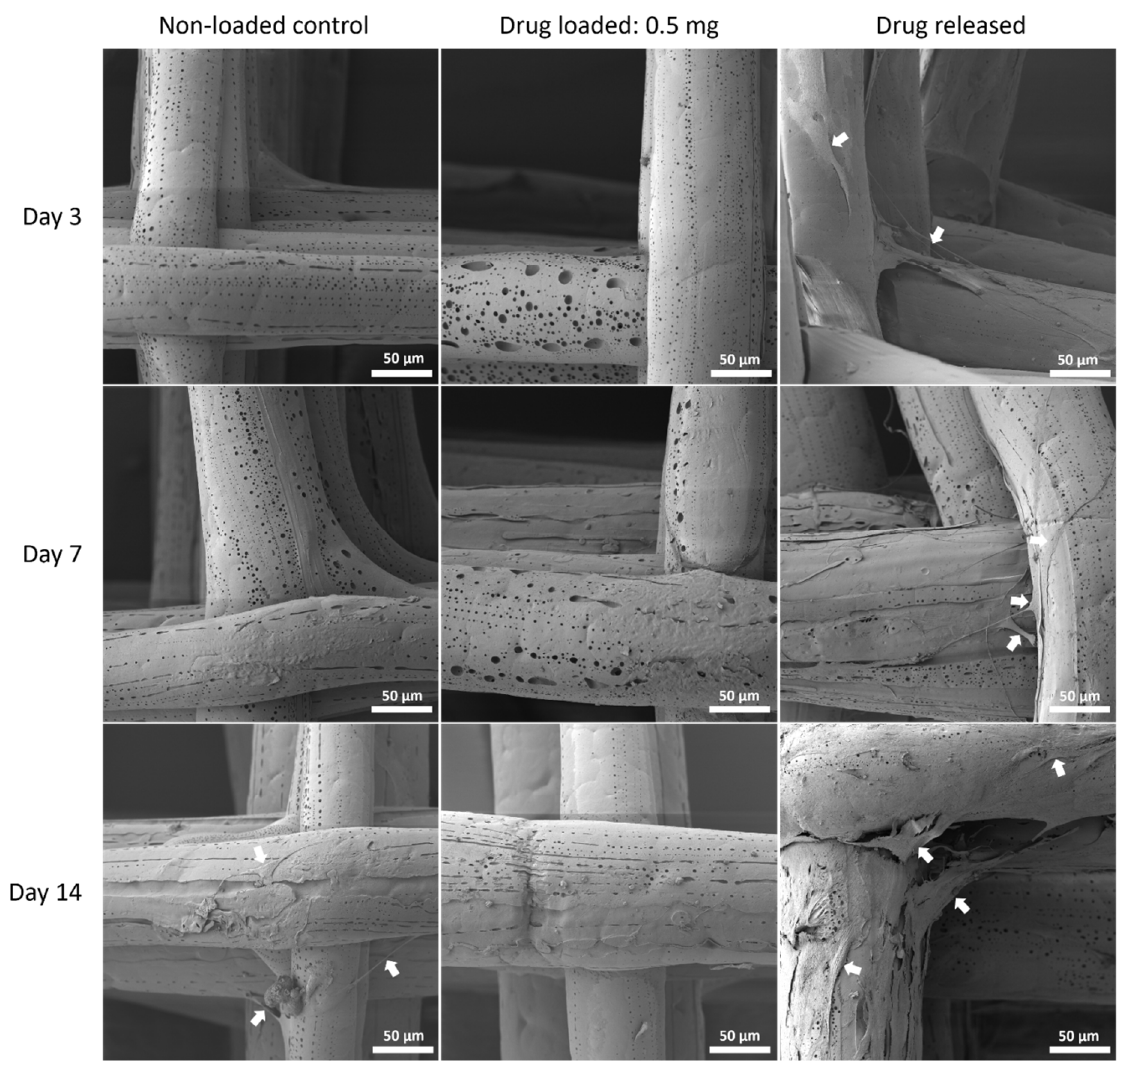
Figure 12. MSC cell morphology on PCL/PEG 75:25 mesh groups at all time points by SEM. Arrows pointing at representative cells or cell sheets attached on mesh fibres.